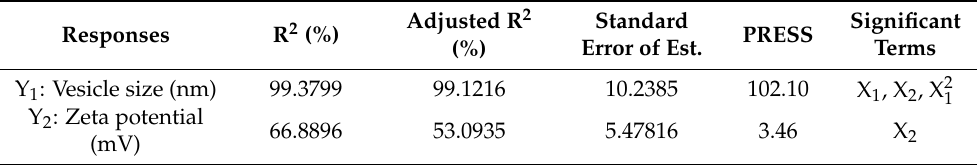
Table 3. Model summary statistics of THQ–PL–SV phytosome responses.